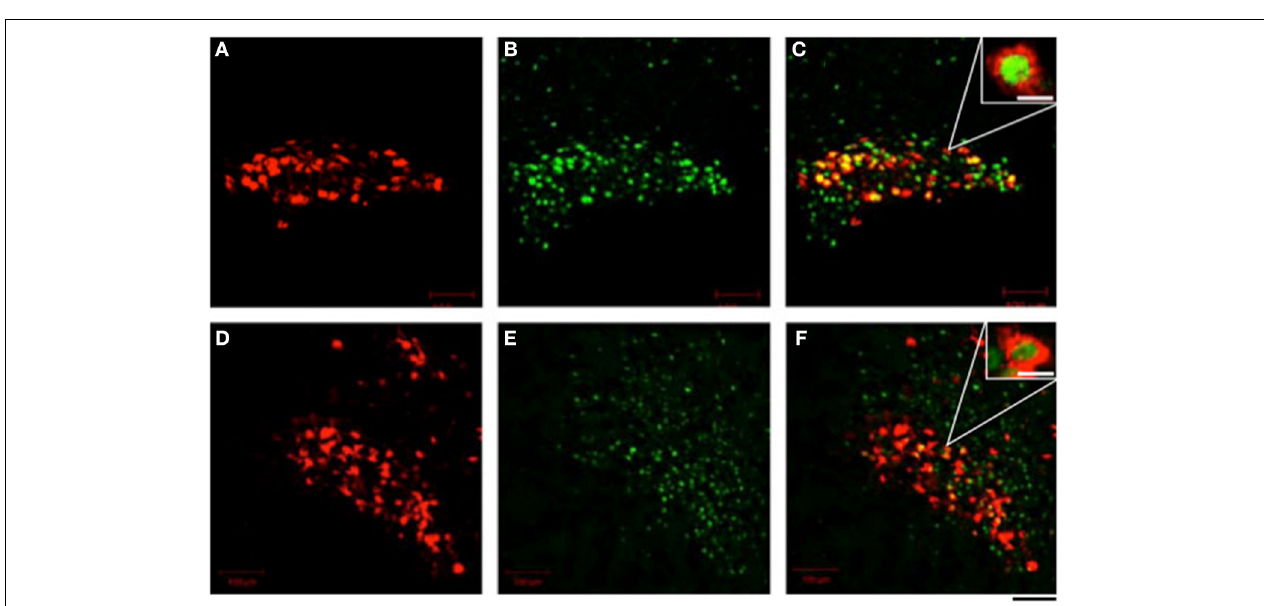
FIGURE 1 | The mRFP1 fluorescence was clearly observed in ventral parts of the supraoptic nucleus (SON) (A,B) and in the PP (C,D) without cutting. Endogenous florescence of mRFP1 in the SON (E) , the paraventricular nucleus (PVN) (F) , the median eminence (ME) (G) , and the posterior pituitary (PP) (H) .